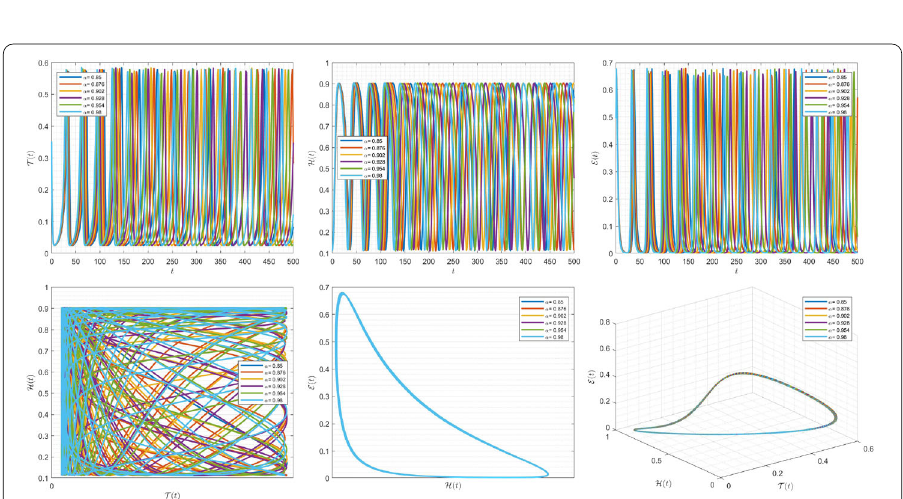
Figure 6 Simulations for solving (29) using (42) along with ( T (0), H (0), E (0)) = (0.3517,0.1115,0.4951) and β 12 =